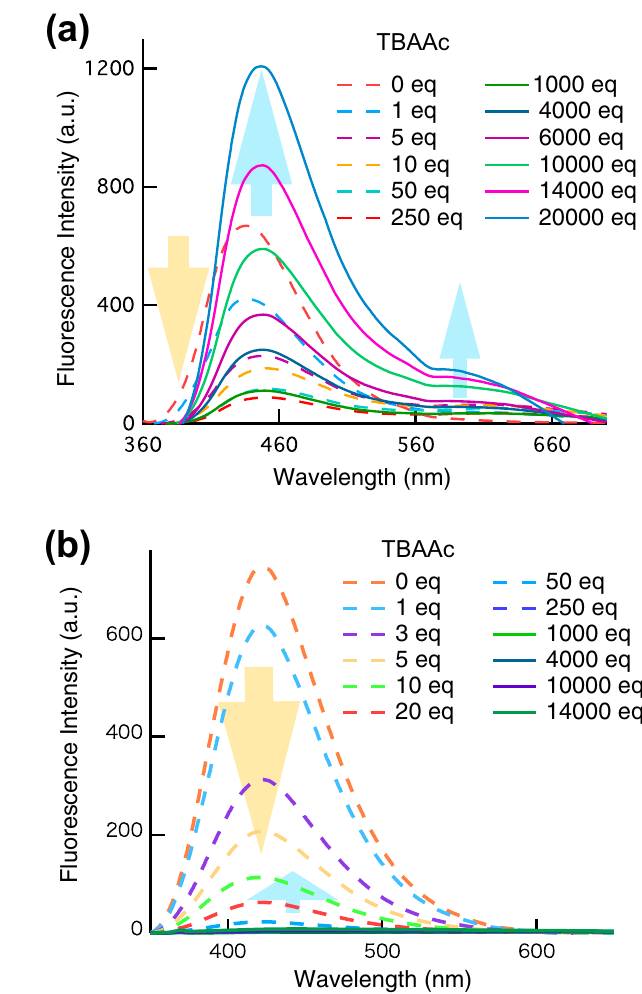
Fig. 3 Changes in fl uorescence spectra. a Fluorescence spectra of a DMSO solution of p -2Urea (150 µ M, λ ex = 359nm) in the absence and presence of different amounts of tetrabutylammonium acetate (TBAAc) (orange dashed = 0 eq; light blue dashed = 1 eq; purple dashed = 5 eq; yellow dashed = 10 eq; yellowish green dashed = 50 eq; red dashed = 250 eq; green = 1000 eq; dark blue = 4000 eq; purple = 6000 eq; yellowish green = 10,000 eq; pink = 14,000 eq; blue = 20,000). b Fluorescence spectra of a DMSO solution of m -2Urea (150 µ M, λ = 332nm) in the absence and presence of different ex amounts of TBAAc (orange dashed = 0 eq; light blue dashed = 1 eq; purple dashed = 3 eq; yellow dashed = 5 eq; yellowish green dashed = 10 eq; red dashed = 20 eq; blue dashed = 50 eq; blue purple dashed = 250 eq; yellowish green = 1000 eq; dark blue = 4000 eq; purple = 10,000 eq; green =